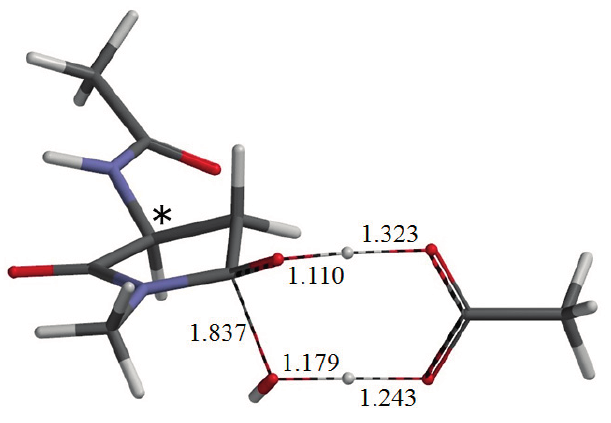
Figure 8. The geometry of the transition state TS-2 of the second step (dehydration) ( φ = − 169°, ψ = − 142°, χ 1 = 144°). The distances of forming and breaking bonds are shown in Å. The asterisk (*) indicates the α carbon.